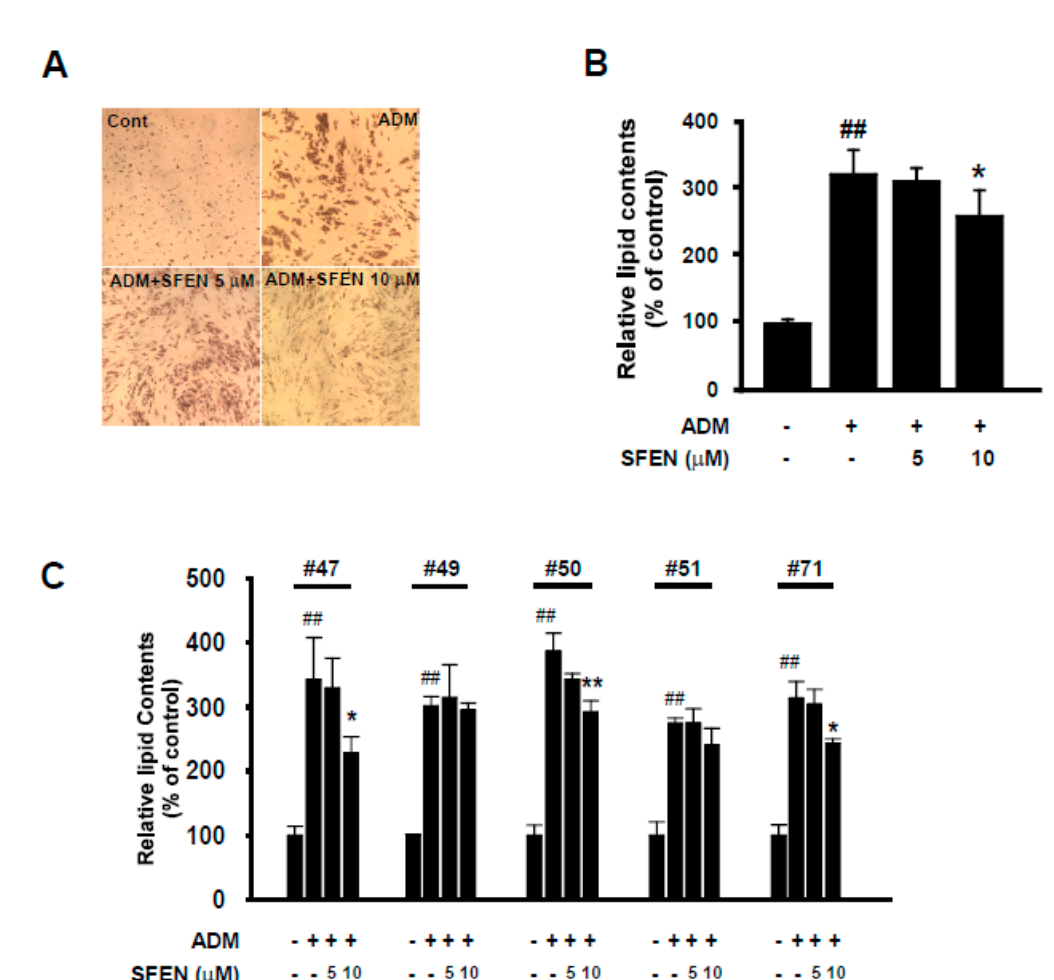
Figure 6. E ff ect of sulforaphene (SFEN) on adipocyte di ff erentiation medium-induced adipogenesis in human adipose tissue-derived stem cells (ASCs). ( A ) Image of di ff erentiated human ASCs from donor #50 stained with Oil Red O on day 14 after HDM treatment (Magnification: 200 × ). ( B ) Intracellular lipid accumulation in di ff erentiated human ASCs. ( C ) Intracellular lipid accumulation in di ff erentiated ASCs from individual donors. ASCs were seeded in 24-well plates at 0.75 × 10 4 cells per cm 2 and incubated in MesenPRO RS medium. Post-confluent ASCs were incubated with or without human adipocyte di ff erentiation medium (HDM) for 14 days. HDM contains DMEM-F12 supplemented with 10% FBS, 0.5 mM IBMX, 50 µ M indomethacin, 1 µ M dexamethasone, 10 µ g / mL insulin, 100 U / mL penicillin, and 100 µ g / mL streptomycin. After 14 days, ( A ) the cells were then stained using Oil-Red O and ( B , C ) intracellular lipid accumulation was quantified. ( C ) Data were obtained from three independent experiments using three di ff erent passages of ASCs for each patient and ( B ) averaged five patients. Data are expressed as the means ± standard deviation ( n = 3). ##, significant di ff erence ( p < 0.01) between the control and the HDM control. Significant di ff erences between a treatment and the HDM control are indicated by * ( p < 0.05) and ** ( p <